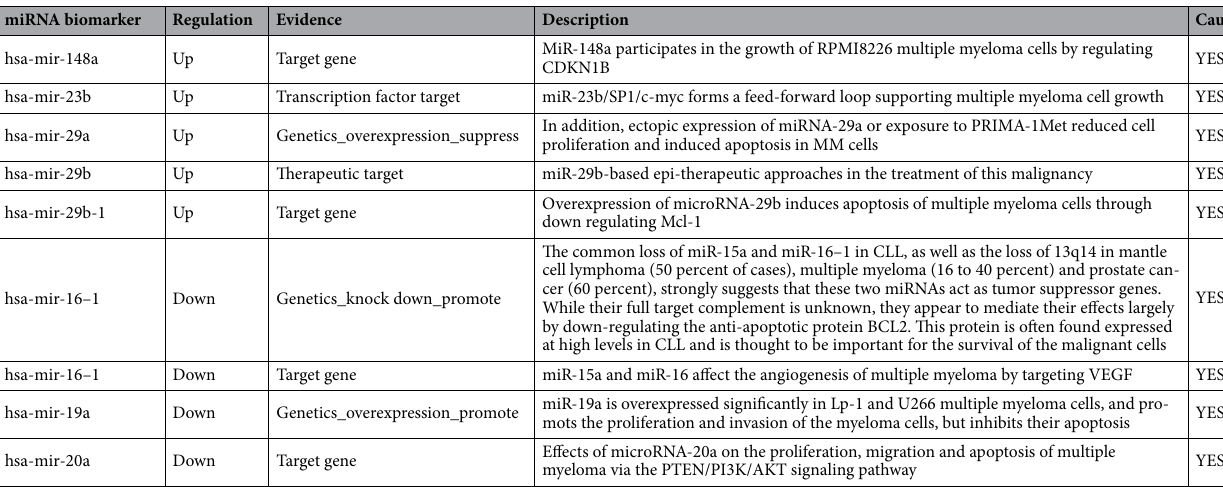
Table 6. List of miRNAs that could result in disease phenotypes (multiple myeloma) when permutated.